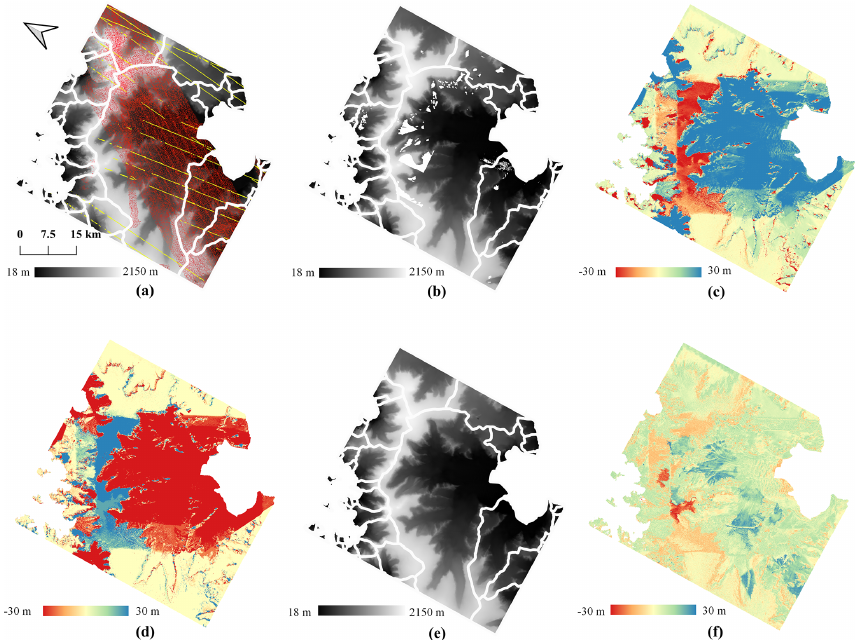
Figure 7. Experimental results of Hektoria and Green (HG) glaciers. (a) Original TDM DEM. Red and yellow: the footprint of LVIS 2015 and ATL06 2019, respectively. (b) Original REMA mosaic with voids. (c) Elevation difference: TDM DEM minus REMA mosaic. (d) Correction map for the TDM DEM. (e) Corrected TDM DEM. (f) Residual elevation difference: corrected TDM DEM minus REMA